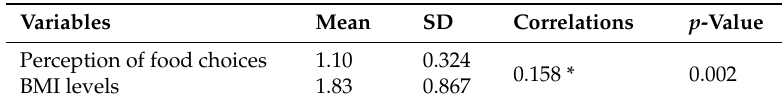
Table 10. Correlation analysis between BMI levels and reproductive-age women’s perception of food choices.